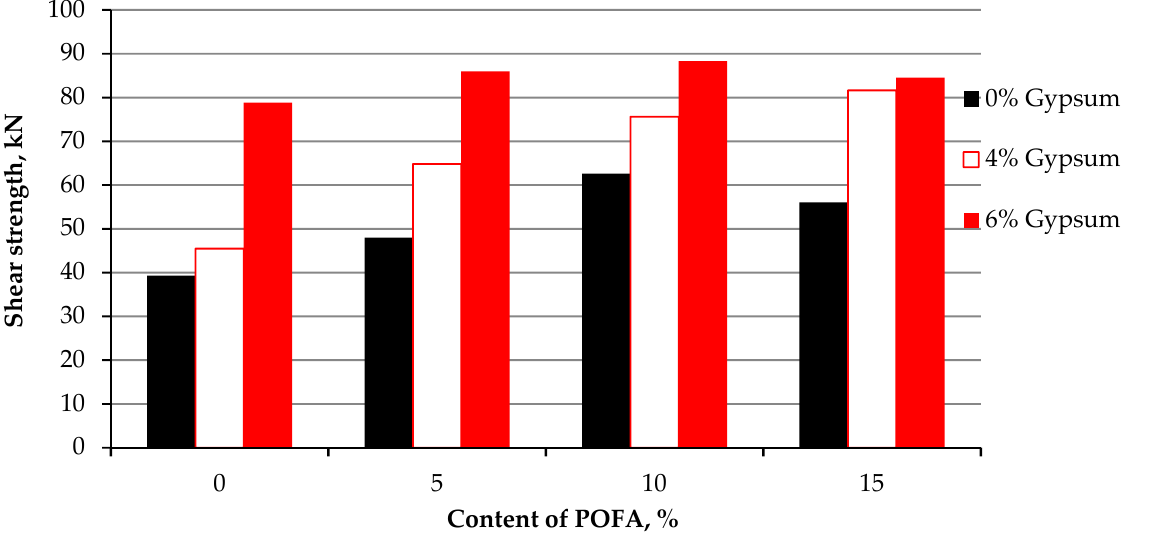
Figure 9. Shear strength of kaolin and stabilized kaolin with gypsum and POFA with no curing—on the 1st day. Table 4. Summary of variance and standard deviation of the specimen of shear strength after one day curing.